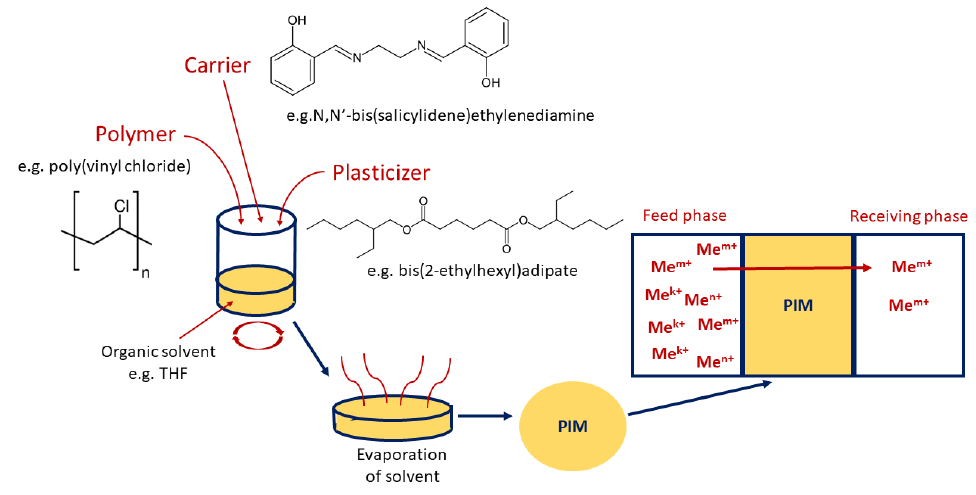
Figure 2. Scheme of formulation of polymer inclusion membrane by casting method (based on